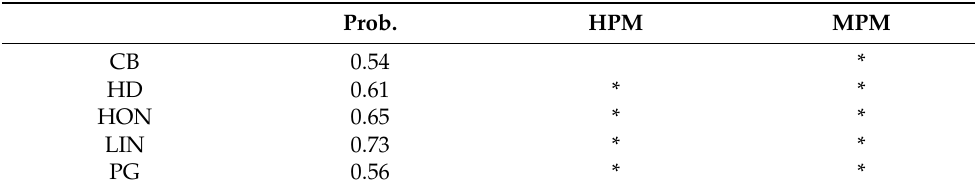
Table 2. Bayesian Variable Selection: Brent price as a dependent variable. Prob. HPM MPM CB 0.54